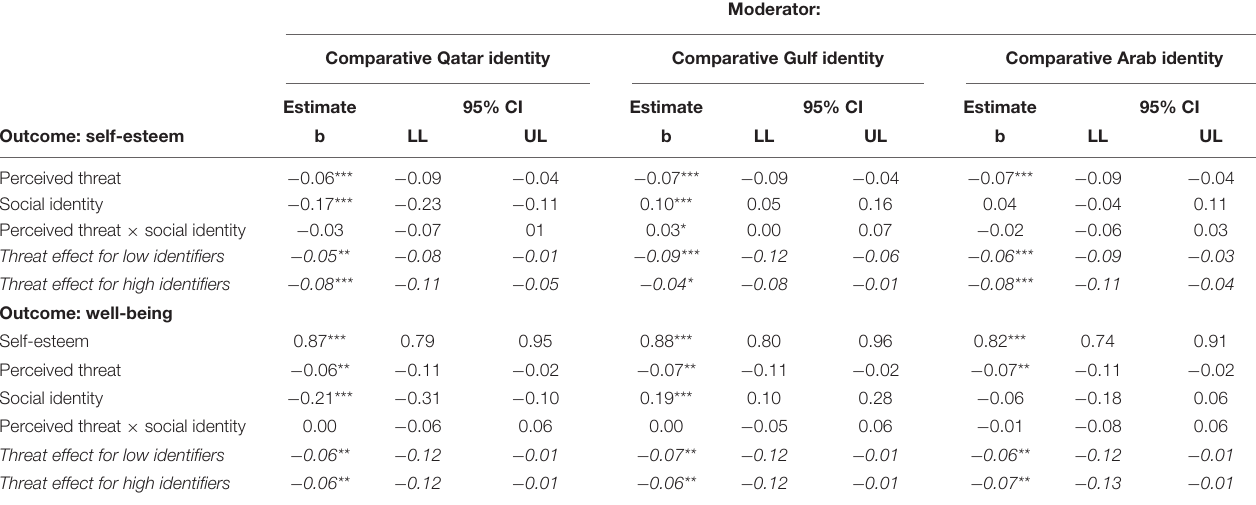
TABLE 4 | Unstandardized estimates and 95% confidence intervals of moderated mediation analyses on self-esteem (upper panel) and well-being (lower panel) for each facet of comparative social identity